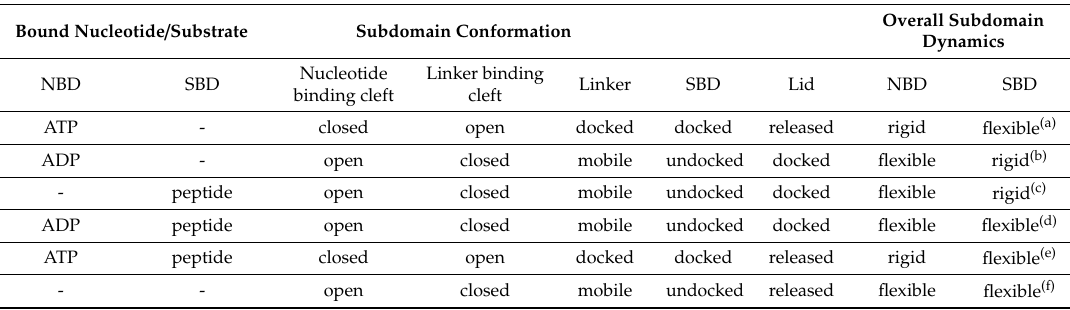
Table 3. Summary of allosteric activity of